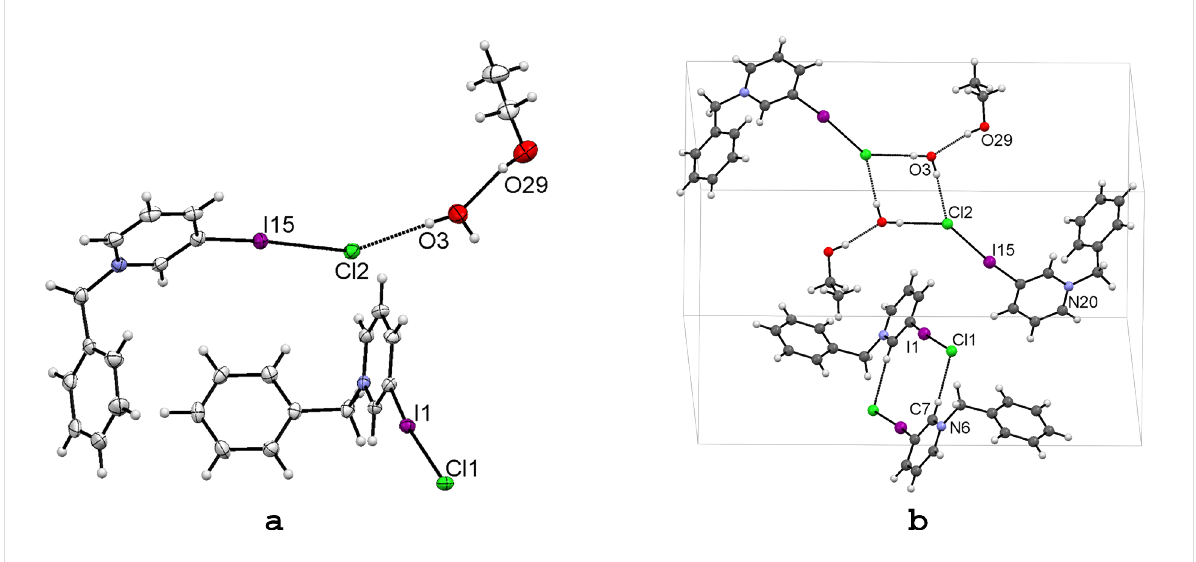
Figure 5: X-ray structure of 3-IPyBnCl ( 9 ) with the selected numbering scheme of the asymmetric unit (a) and selected packing scheme viewed down the a axis (b). Thermal ellipsoids are drawn at the 50% probability level. Hydrogen and halogen bonds are shown in dotted lines.